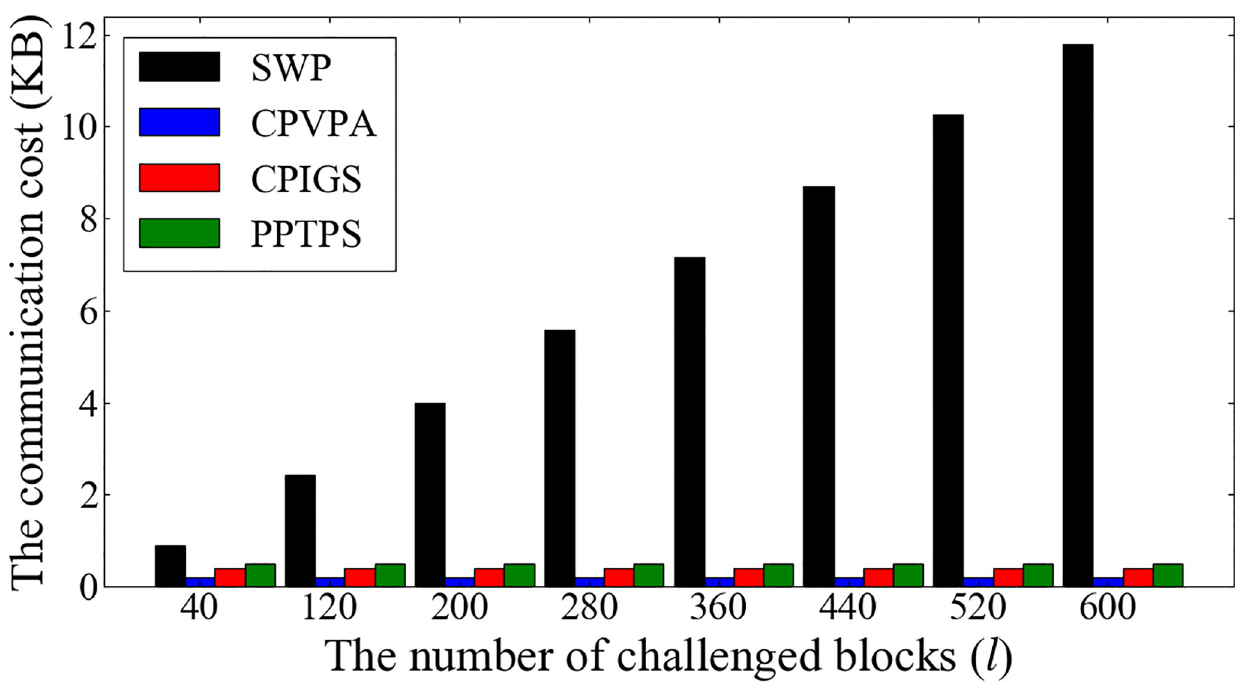
Fig 6. The communication cost between the CSP and the